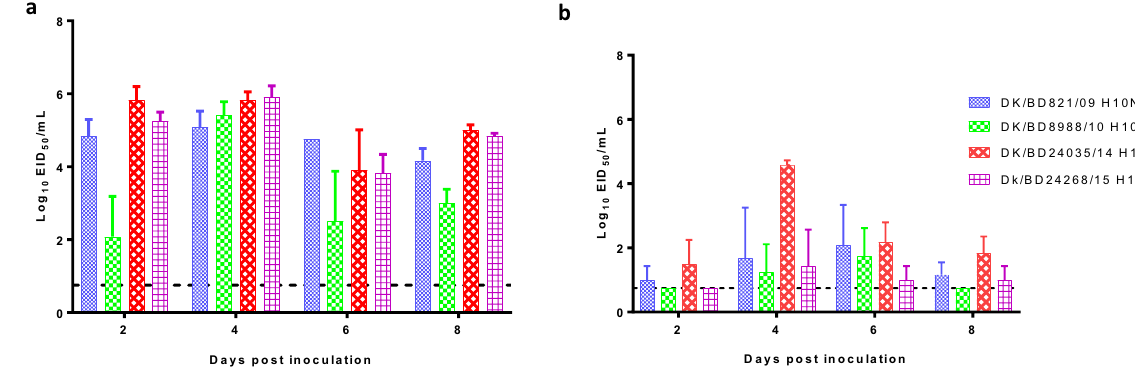
Figure 3. Replication of H10 AIVs in the lungs and nasal turbinates of inoculated mice. DBA/2J mice (n = 3) were infected with 10 6 EID 50 of DK/BD821/09 H10N7, DK/BD8988/10 H10N9, DK/BD24035/14 H10N1, or Dk/BD24268/15 H10N6. Lungs ( a ) and nasal turbinates ( b ) were collected at 2, 4, 6, and 8 dpi, and viral titers were determined by EID 50 assays. The results are expressed as log 10 EID 50 of tissue; error bars depict standard deviations; and the dotted line indicates the lower limit of detection of infectious